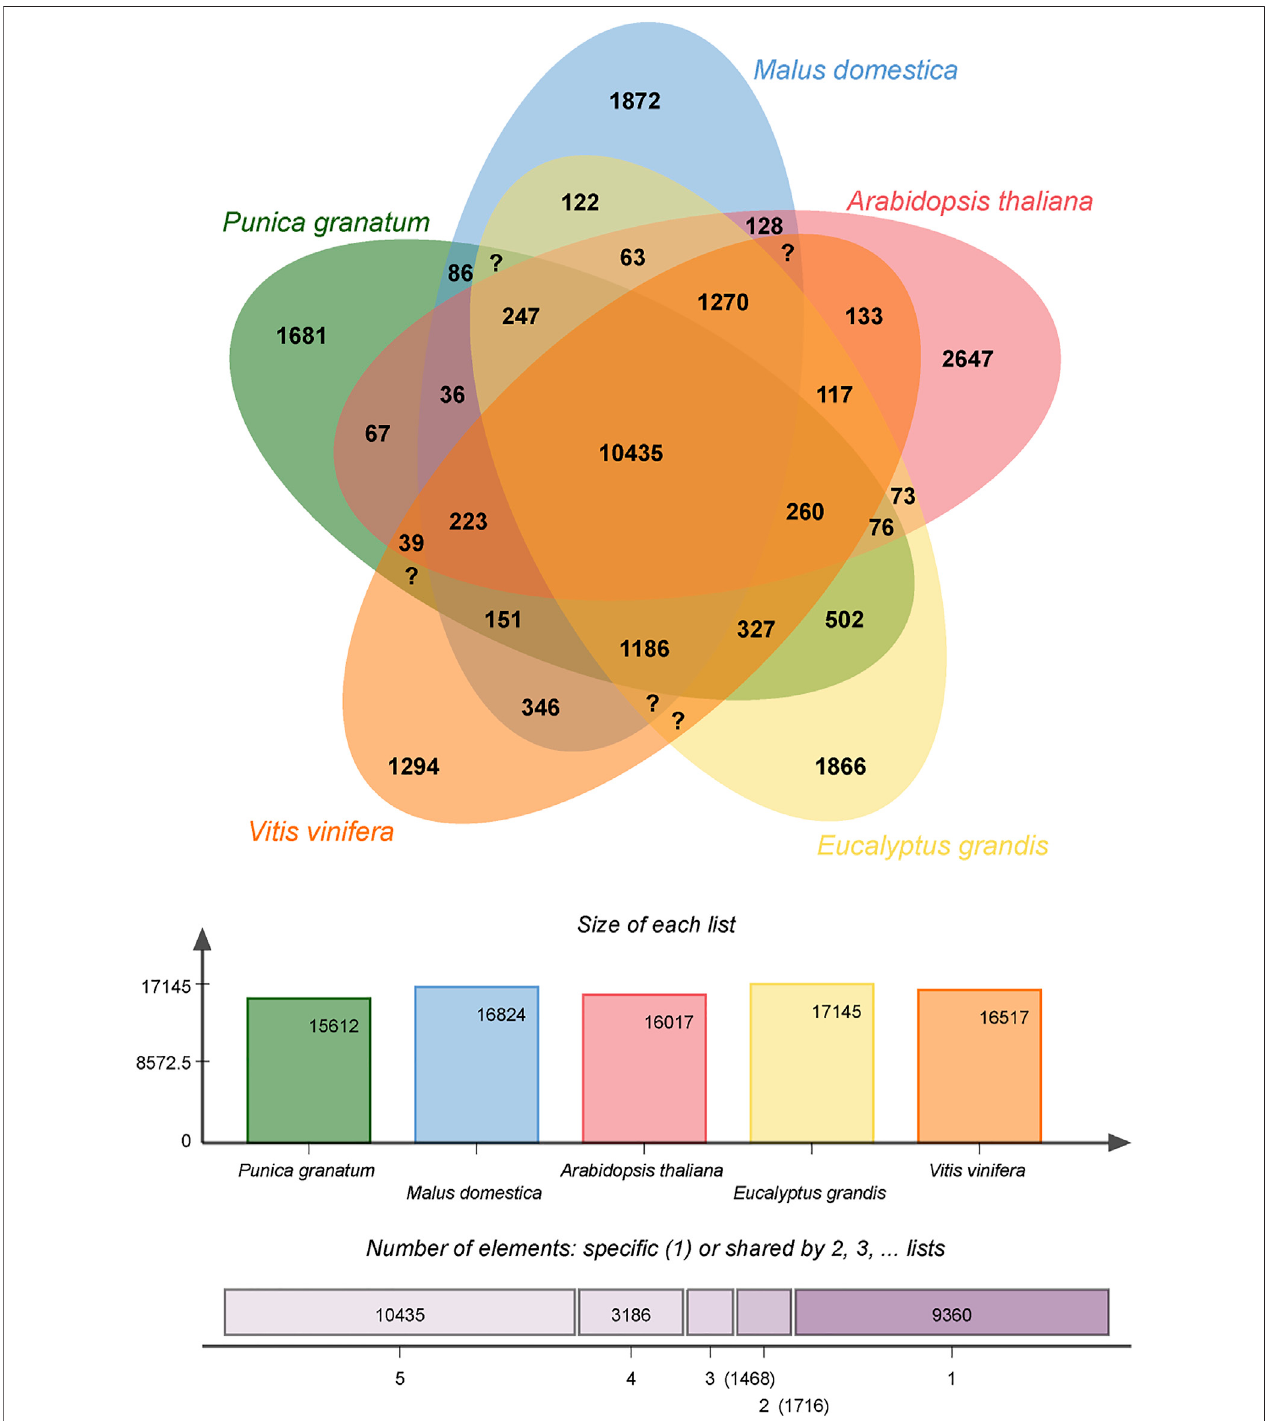
FIGURE 6 | Venn diagram of shared orthologous gene families in Punica granatum , Eucalyptus grandis , Malus domestica , Vitis vinifera , and Arabidopsis thaliana . The gene family number is listed in each component.